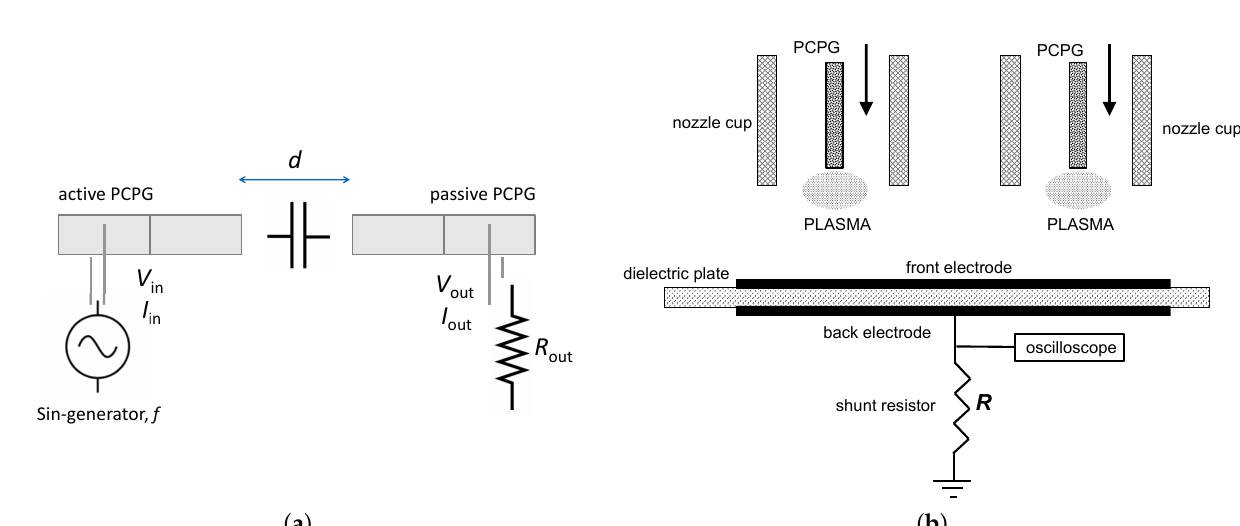
Figure 1. The setup for electric characterization by use of: ( a ) energy transfer efficiency between two PCPGs, and ( b ) capacitive probe